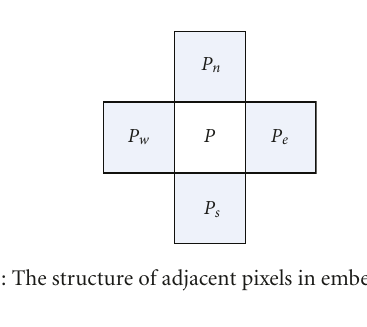
an image. Half of the pixels were used for embedding